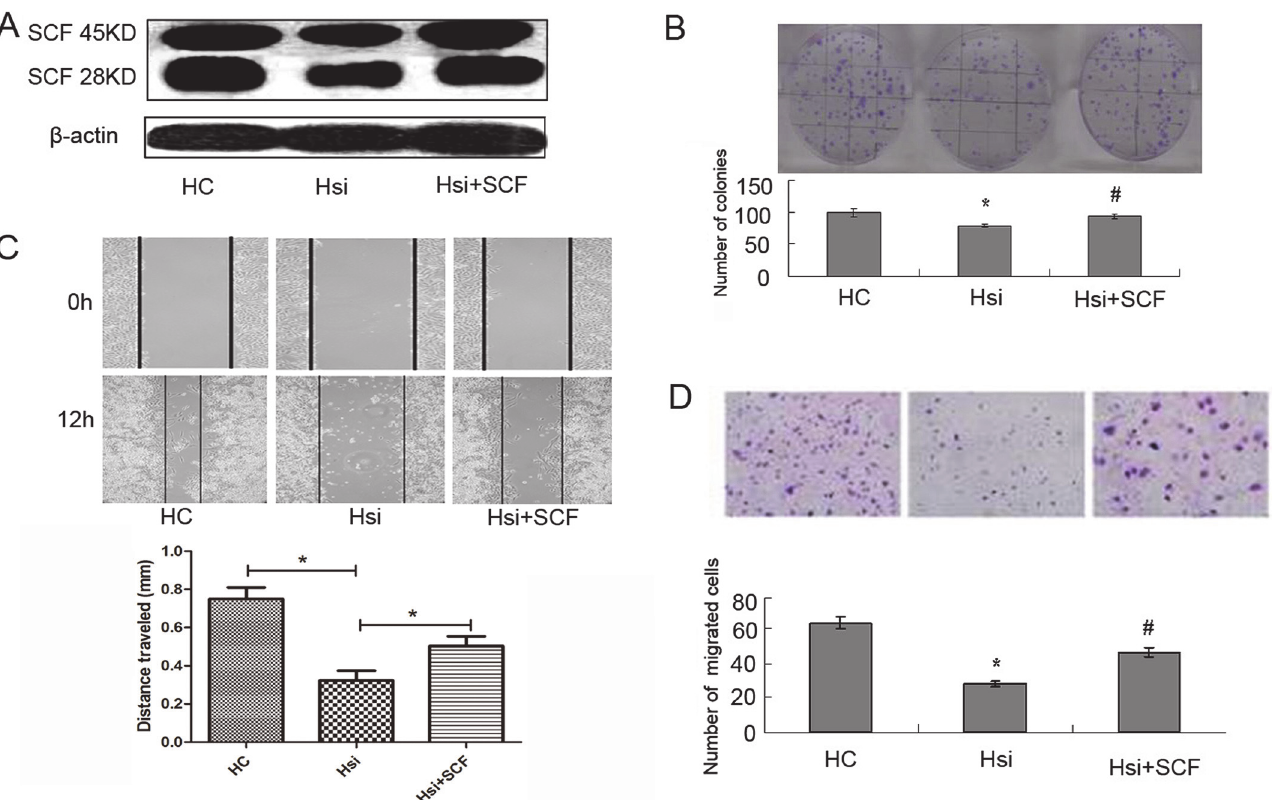
Fig 5. PDAC cells proliferation and invasion abilities can be rescued by up-regulation SCF following HIF-1 α knockdown. (A): The levels of HIF-1 α and SCF protein were tested via Western blot in different groups: The SCF protein level can be rescued by adding exogenous SCF when transfected with siRNA targeting HIF-1 α at the same time. (B): Colony formation results in different groups: the decreased tumor cells proliferation rate following HIF-1 α knockdown can be rescued by up-regulation of SCF (p < 0.05, respectively). (C): The scratch results in different groups: the decreased tumor cells proliferation rate following HIF-1 α knockdown can be rescued by up-regulation of SCF (p < 0.05, respectively). (D): Transwell chambers results in different groups: the decreased tumor cells through the membrane following HIF-1 α knockdown can be rescued by up-regulation of SCF (p < 0.05, respectively). * stands for p < 0.05 (siRNA-HIF-1 α group VS control group), and # stands for p < 0.05 (siRNA-HIF-1 α +SCF group VS siRNA-HIF-1 α group).